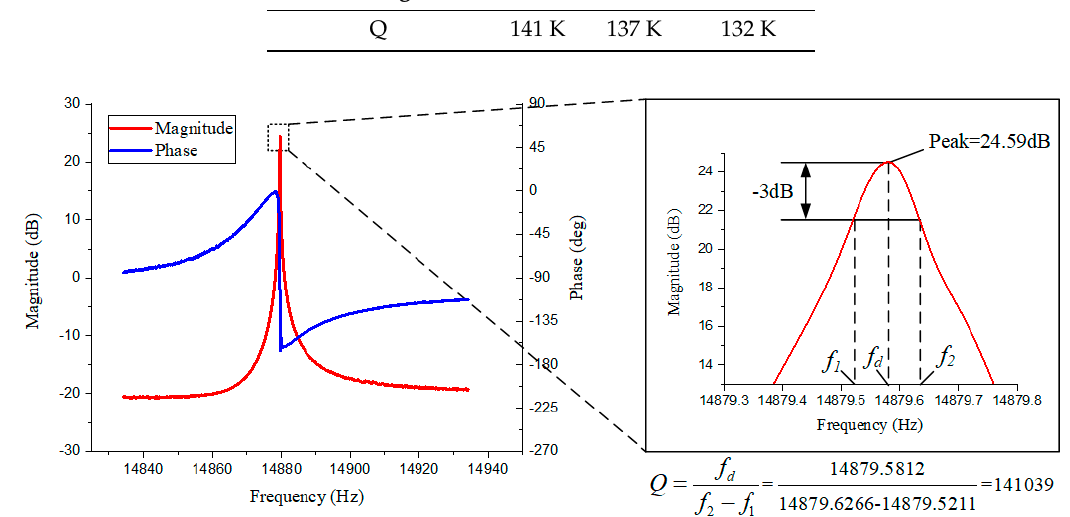
Figure 12. The resonance peak and phase of the DRG 5 with the highest Q.